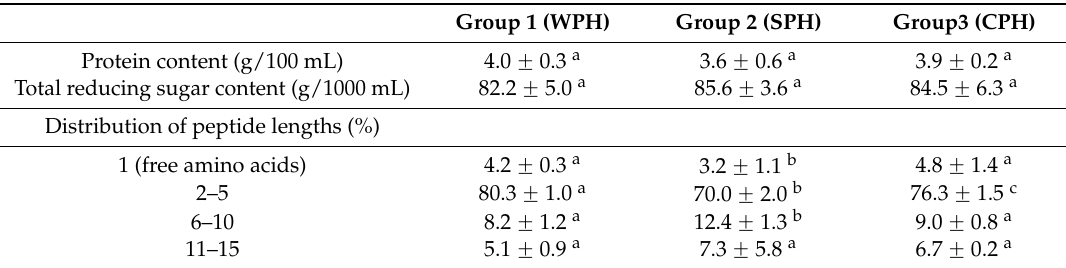
Table 3. Protein content, total reducing sugar content and peptide lengths distribution in commercial PED